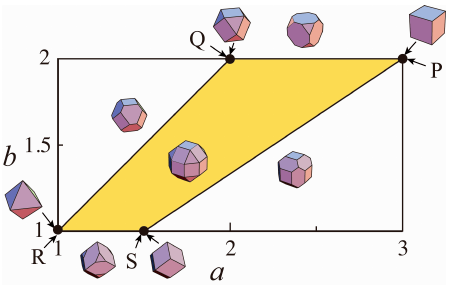
Figure 2. Diagram showing the variations of polyhedra composed of {100}, {111} and {110} as the limiting shapes of the extended superspheres The parameters a and b are those for determining the ratios of the {100}, {111} and {110}. The points P, R and S respectively correspond to the {100} hexahedron, the {111} octahedron and the {110} dodecahedron. Polyhedra composed of one or two of the crystallographic planes can be shown around the quadrilateral surrounded as shown in the insets. The {100}-{111}-{110} polyhedra with different ratios of the three crystallographic planes are expressed inside of the